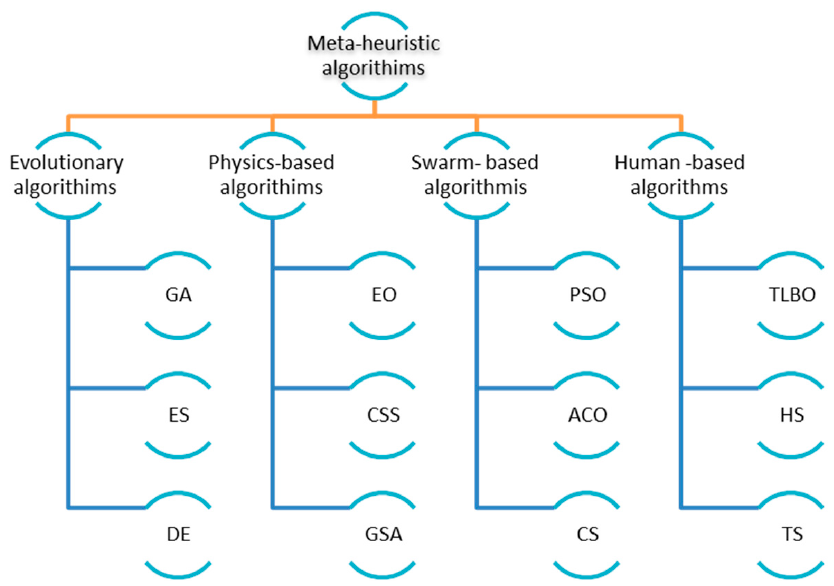
Teaching Learning Based Optimization (TLBO) [13], Harmony Search (HS) [14] and Tabu (Taboo) Search (TS) [15].